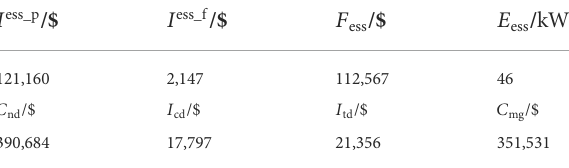
TABLE 4 Con fi guration results of centralized shared energy storagein the